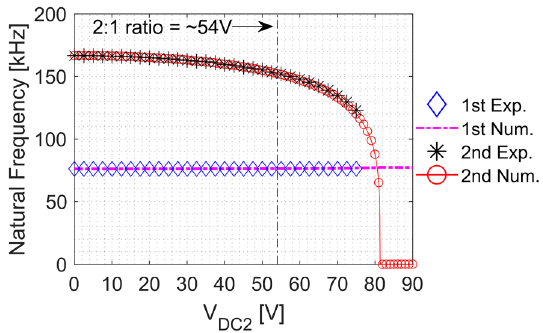
Figure 4. Natural frequency shifts of the first two modes due to the effect of the electrostatic force when actuating the structure through E2. Experimental data and numerical simulations show excellent agreement and reveal a possible 2:1 internal resonance at V DC2 = 54 V. Note that the actuation of the 2nd mode does not affect the 1st